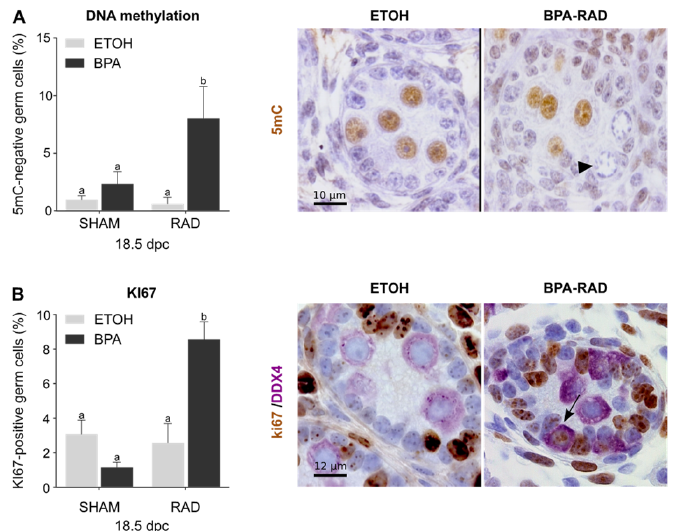
Figure 3. BPA and RAD co-exposure in utero induce gonocyte exit from quiescence. Fetal (18.5 dpc) testes from exposed mice (BPA, RAD or combined exposure) or unexposed (ETOH as control) mice were collected for immunohistological analyses. ( A ) Percentage of 5-methylcytosine (5 mC)-nega- tive germ cells. Each bar represents the mean ± sem from 5–7 independent samples. Means with different letters are significantly different ( p < 0.05; two-way ANOVA followed by a Tukey test).